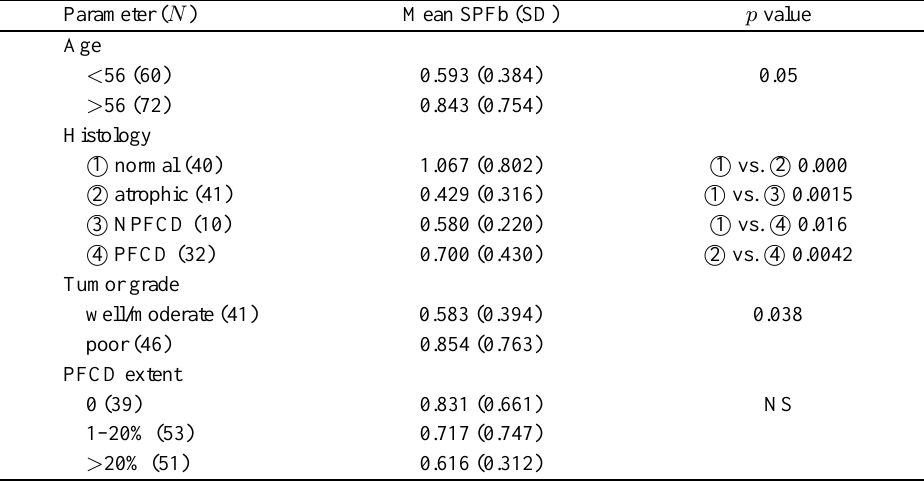
Correlations between benign breast epithelial cell proliferation (SPFb) and clinicopathologic